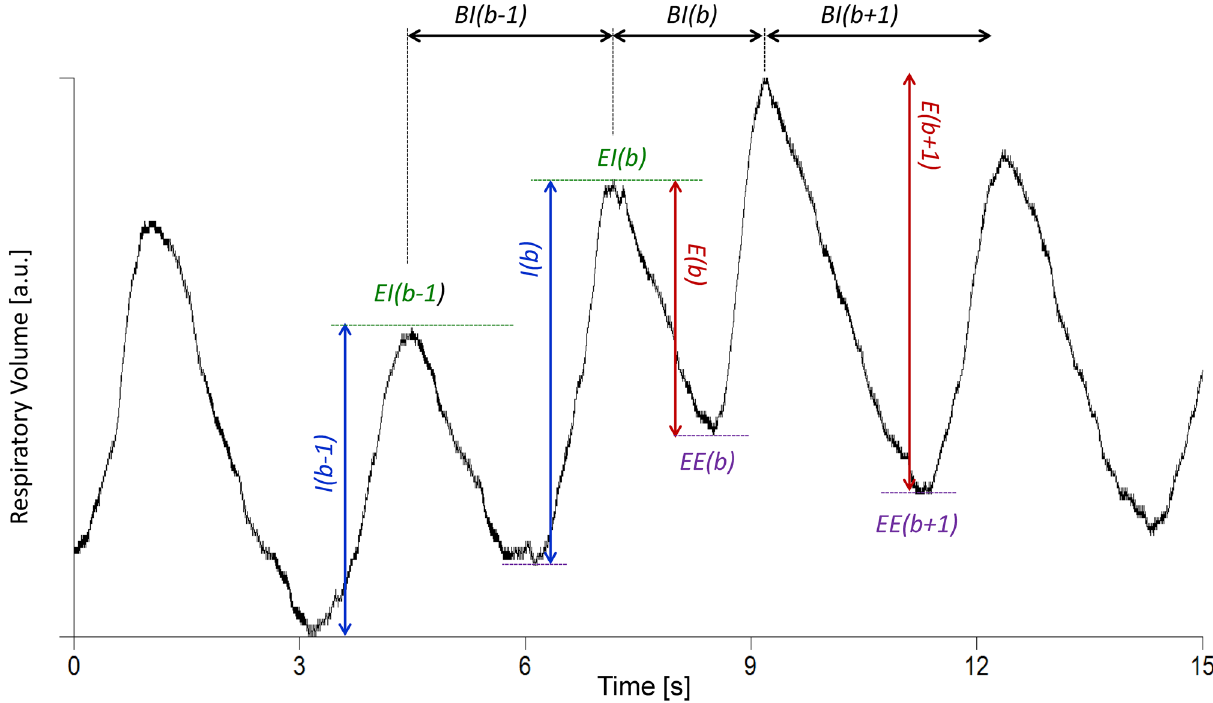
Figure 1. Breath-by-breath respiratory series. From the respiratory volume sampled at 200 Hz (continuous black line) we extracted 5 breath-by-breath series: the end-inspiratory (EI, green dashed line) and end- expiratory (EE, purple dashed line) volumes; the inspiratory (I, blue arrow) and expiratory (E, red arrow) volumes; and the breathing interval (BI, black arrow). For a given breath b , the EI volume is the maximum respiratory volume within the breath; the EE volume is the minimum respiratory volume between the EI volumes of breaths b and b + 1; I volume is the difference between the EI volume of the breath b and the EE volume of the breath b − 1 while the E volume is the difference between the EI and EE volumes of the same breath b ; finally, BI is the time interval between consecutive EI